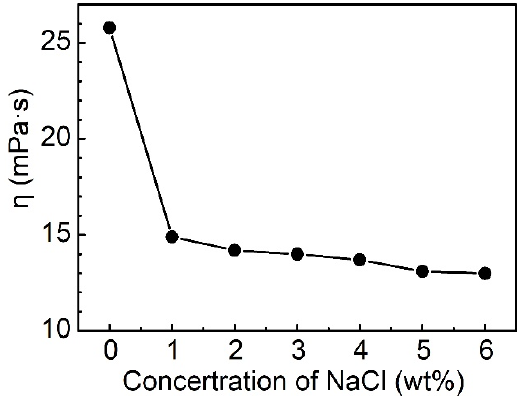
Figure 8. The effect of NaCl on the viscosity reduction performance of OA and cyclen. The total concentration of OA and cyclen (molar ratio= 4:1) was 3.0 wt%, and the mass ratio of oil and OA/cyclen aqueous solution was set as 7:3.